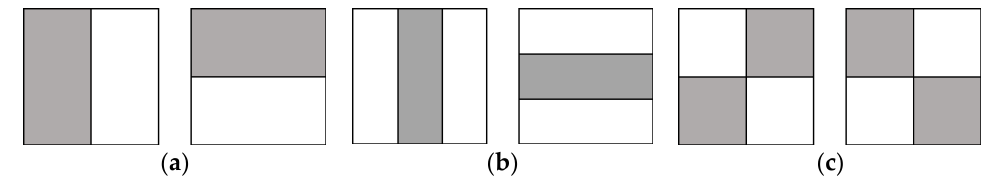
Figure 1. Examples of the rectangle (Haar-like) features. ( a ) Two-rectangle features. ( b ) Three-rectangle features. ( c ) Four-rectangle features.